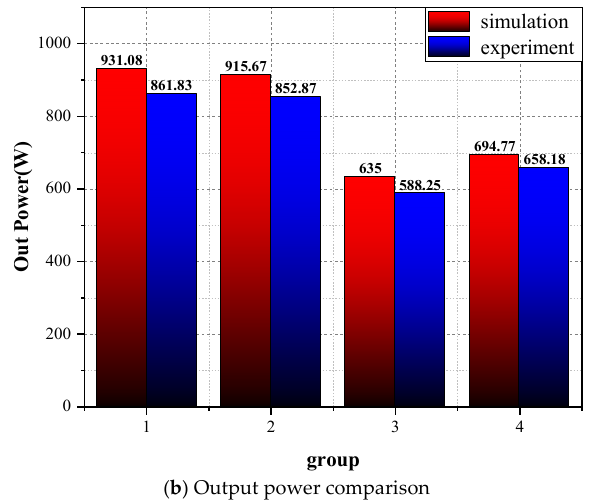
Figure 12. Compensation network interoperability experimental results.